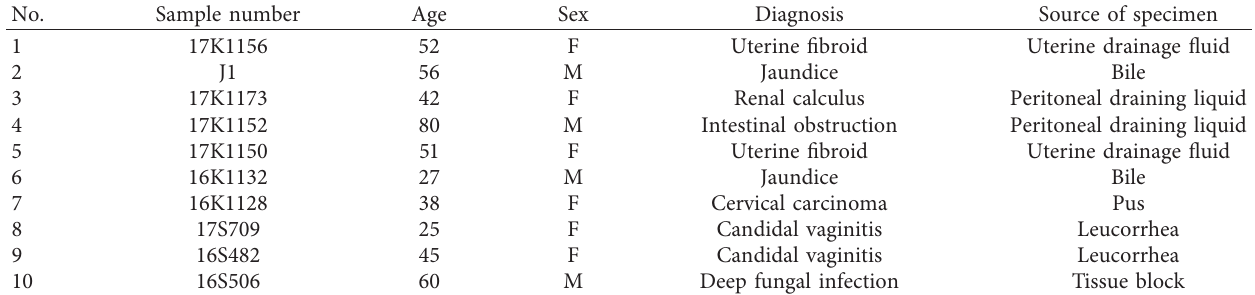
Table 1: Clinical information of clinical strains.